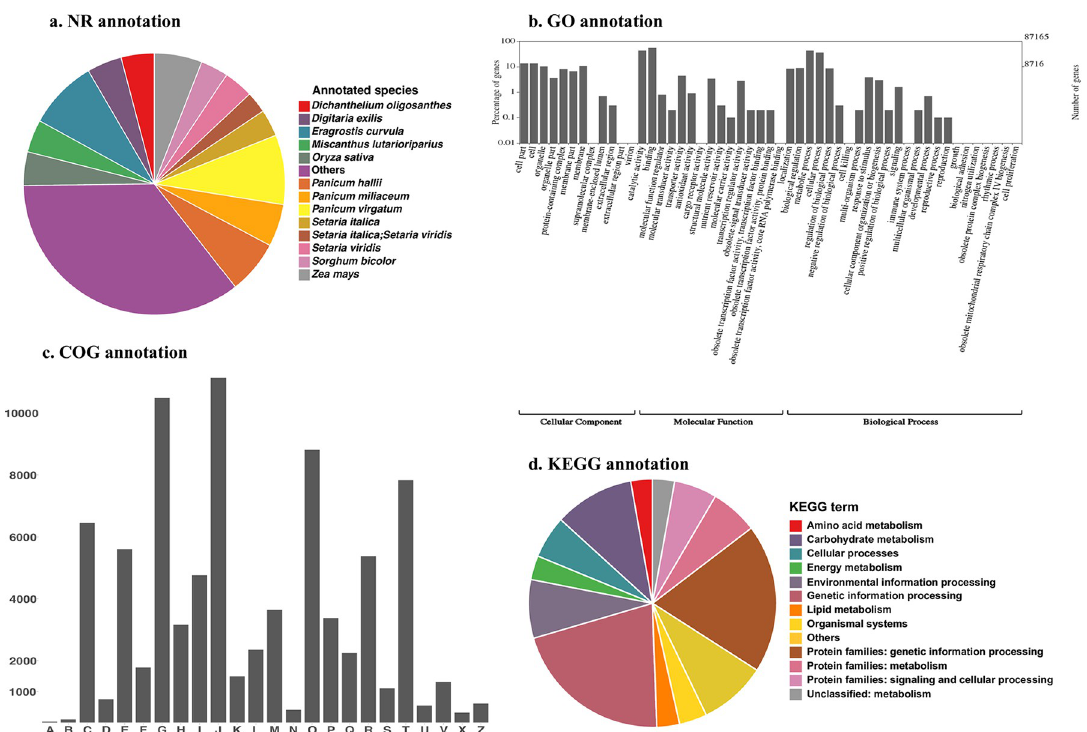
Fig 3. Transcriptome annotation from four database. a. Species distribution of the blastx hits for all homologous sequences against the NR database; b. Distribution of Gene Ontology (GO) classification. 87,165 transcripts have the GO annotation and are classified into 3 functional categories: cellular component, molecular function, and biological process. WEGO 2.0 (52) was used to classify GO terms and present them in this histogram figure; C. Distribution of COG functional classification by using transcriptome assembly file. 87,165 transcripts have COG annotation by using the transcriptome assembly file. The 25 categories are: [A] RNA processing and modification, [B] Chromatin structure and dynamics, [C] Energy production and conversion, [D] Cell cycle control, cell division, chromosome partitioning, [E] Amino acid transport and metabolism, [F] Nucleotide transport and metabolism, [G] Carbohydrate transport and metabolism, [H] Coenzyme transport and metabolism, [I] Lipid transport and metabolism, [J] Transition, ribosomal structure and biogenesis, [K] Transcription, [L] Replication, recombination and repair, [M] Cell wall/membrane/envelope biogenesis, [N] Cell motility, [O] Posttranslational modification, protein turnover, chaperones, [P] Inorganic ion transport and metabolism, [Q] Secondary metabolites biosynthesis, transport and catabolism, [R] General function prediction only, [S] Function unknown, [T] Signal transduction mechanisms, [U] Intracellular trafficking, secretion, and vesicular transport, [V] Defense mechanisms, [W] Extracellular structure, [Y] Nuclear structure, and [Z] Cytoskeleton; d. Distribution of KEGG terms. 95,137 transcripts have KEGG terms and are grouped based on KEGG classification. The result is from GhostKOALA [47] by using the predicted protein coding